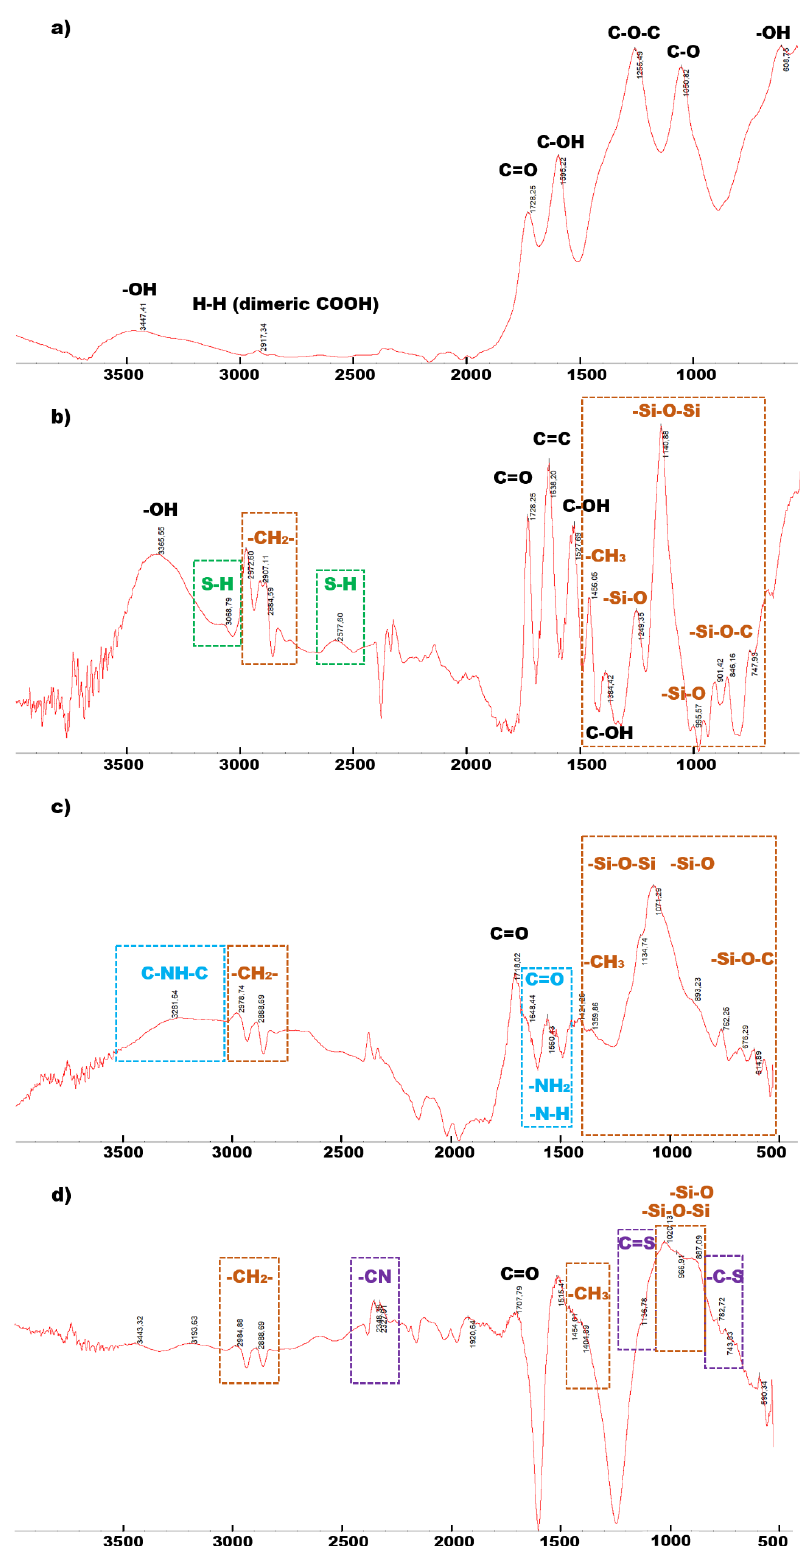
Figure 2. FTIR results for blank: ( a ) reduced graphene oxide monolith rGO60_0.5; ( b ) S60_0.5; ( c ) N90_2; ( d )